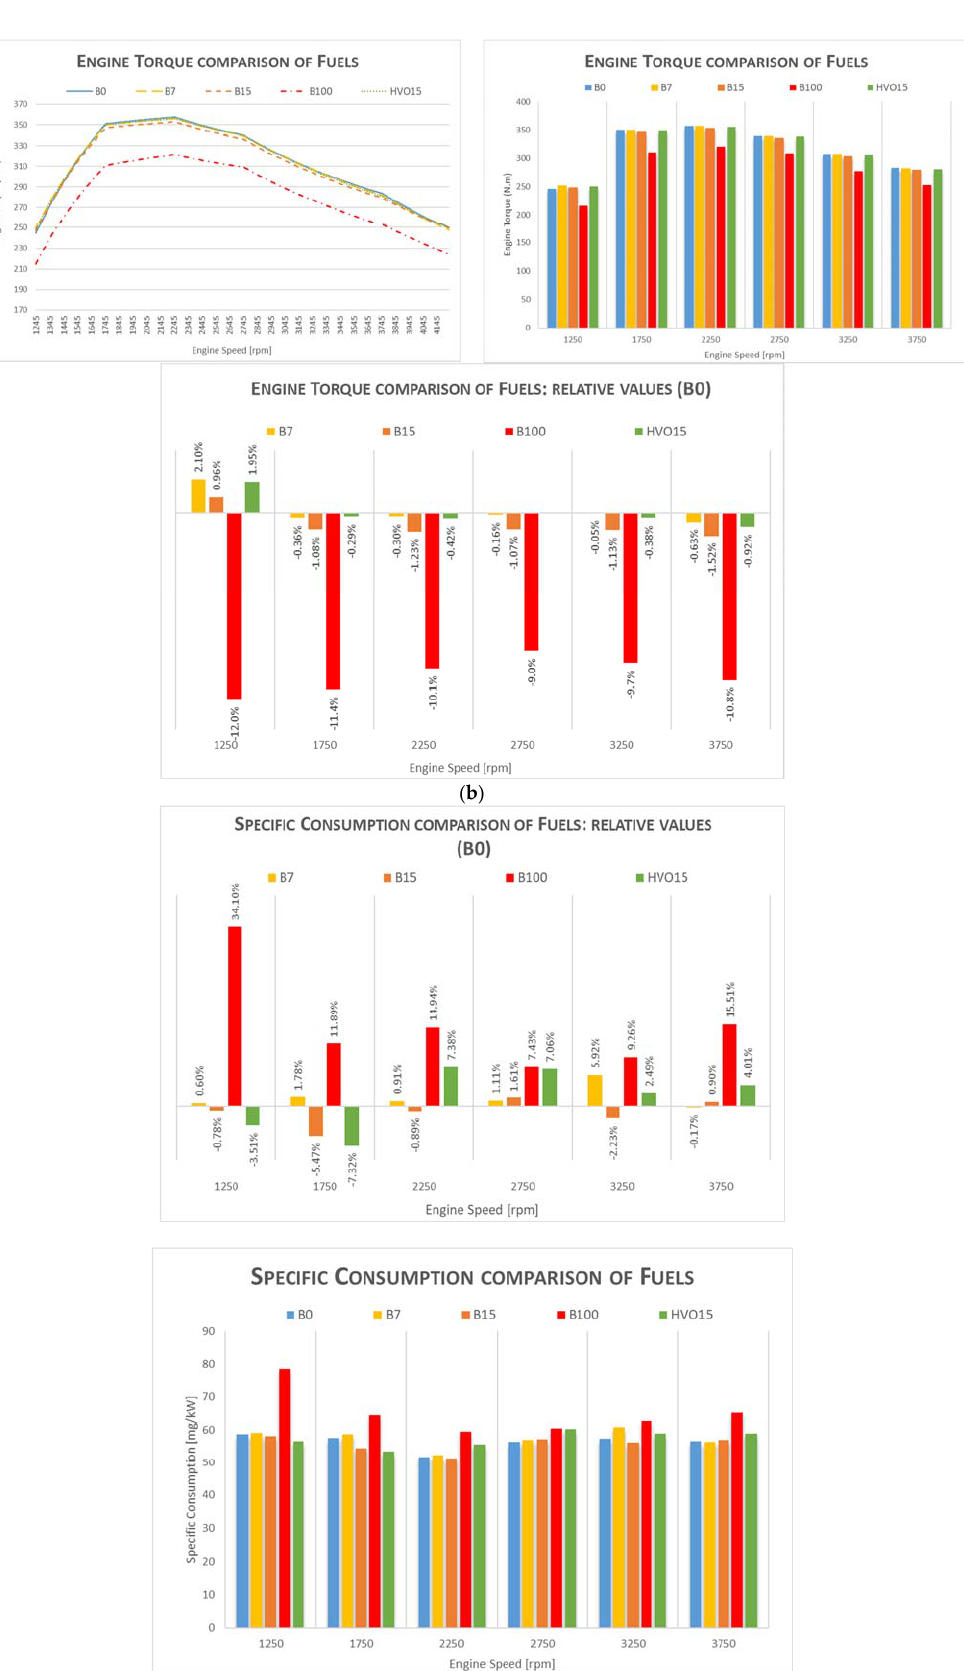
Figure 7. ( a ) Results obtained from the power test (power). ( b ) Results obtained from the power test (torque). ( c ) Results obtained from the power test (specific fuel consumption).